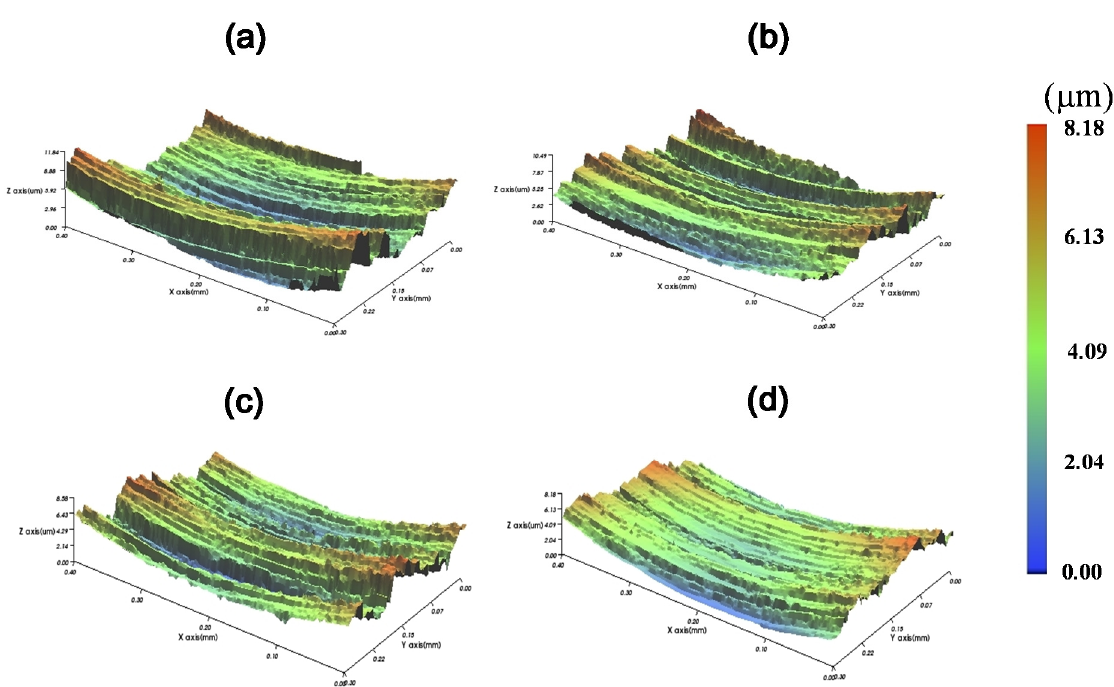
Figure 7. Profiles of ground surfaces of Ti- x In alloys at a grinding speed of 10,000